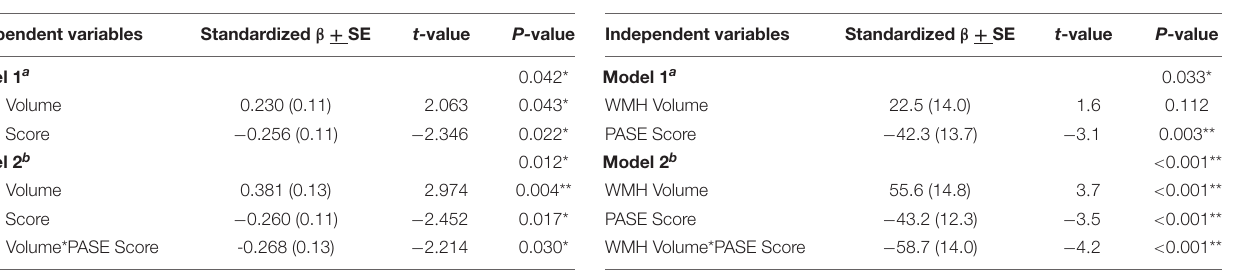
TABLE 3 | Results of the exploratory linear regression analyses of foam sway.